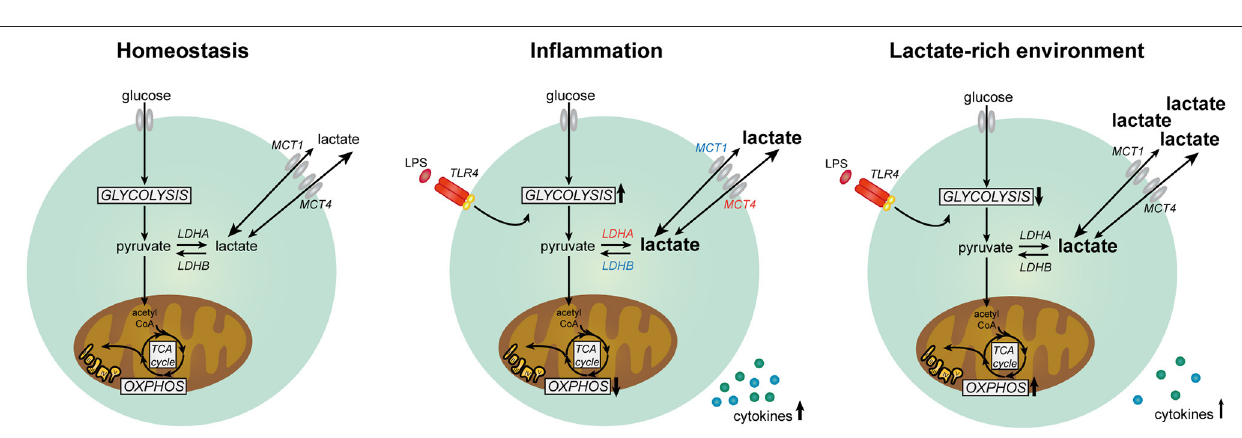
FIGURE 11 | Lactate metabolism in human immune cells. Overview of the role of lactate in modulating metabolism and function in human immune cells. Expression of genes marked in red was upregulated and expression of genes marked in blue was downregulated in human immune cells upon stimulation with LPS.